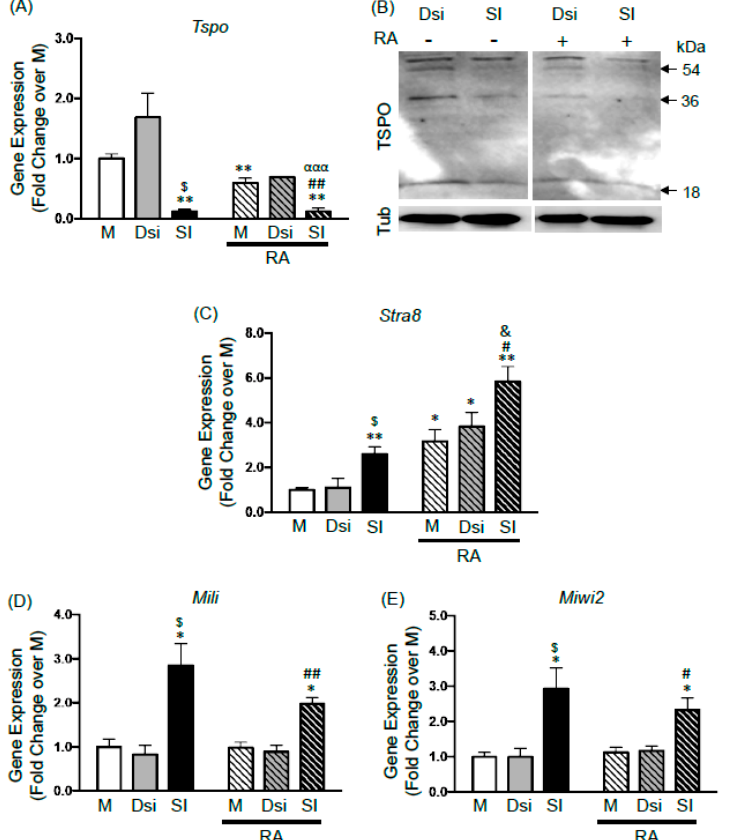
Figure 3. Effect of TSPO knockdown on gene expression in gonocytes. Silencing experiments were performed as described in the method section, by treating isolated gonocytes with either medium (mock; M), non-targeting DsiRNA (Dsi), or TSPO siRNA (SI) for 24 h (RNA analysis) or 48 h (protein analysis), followed by an additional 24 h incubation with or without RA (10 − 6 M). ( A ) Tspo mRNA expression. Results shown are from 3 independent germ cell preparations (each condition done in duplicate) and are plotted as mean ± SEM. * p -value < 0.05; and ** p -value < 0.01 compared to M;